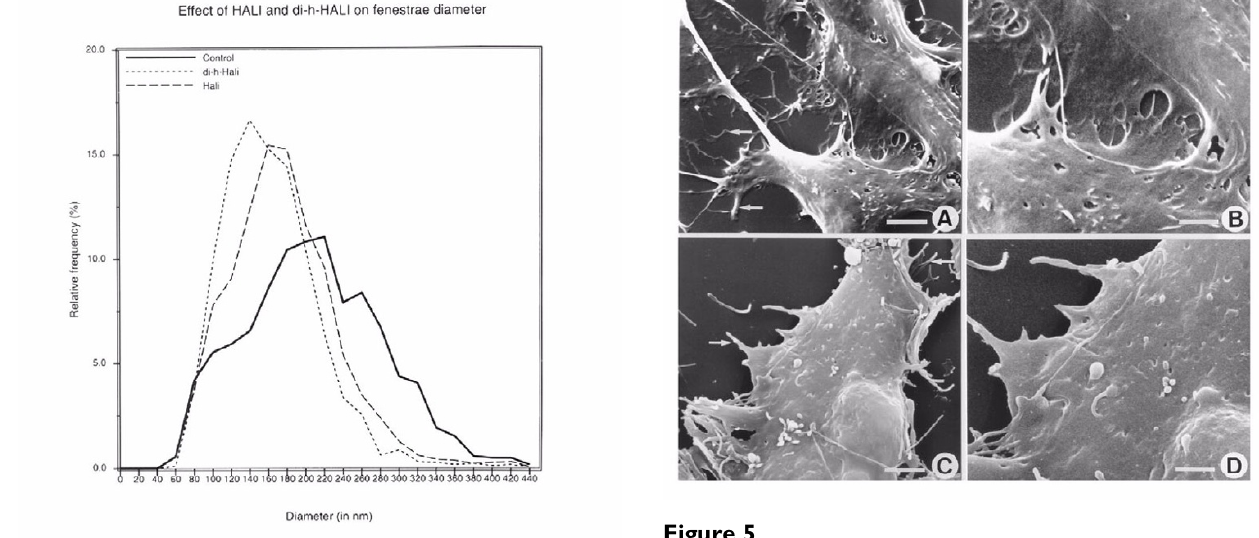
Figure 5 SEM observations of HUVECs (A-B) and BECs STR-4 (C-D) treated with 100 nM di-h-HALI for 120 min. ( A ) HUVECs exposed to di-h-HALI show significant signs of cell contraction; i.e. the cytoplasm is retracted and numerous fine cytoplasmic extensions appear (arrows). Scale bar, 5 µ m. ( B ) High magnification image of the cytoplasm shows a smooth surface and the lack of fenestrated structures (com- pare with Fig. 2C for the difference with LSECs). Scale bar, 2.5 µ m. (C-D) di-h-HALI treated BECs STR-4 show features similar to those seen in A and B (scale bars [C] 5 µ m, [D] 2.5 µ